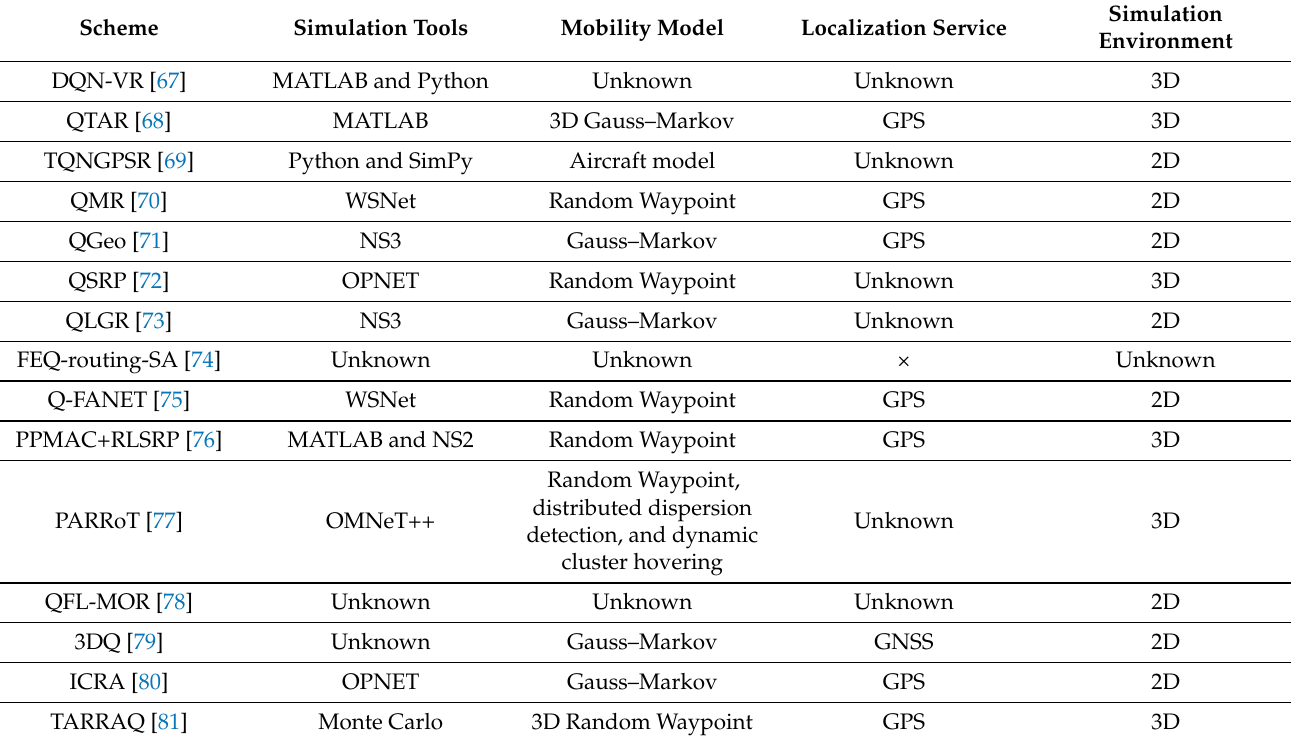
Table 24. Comparison of RL-based routing protocols in terms of simulation environment and tools.